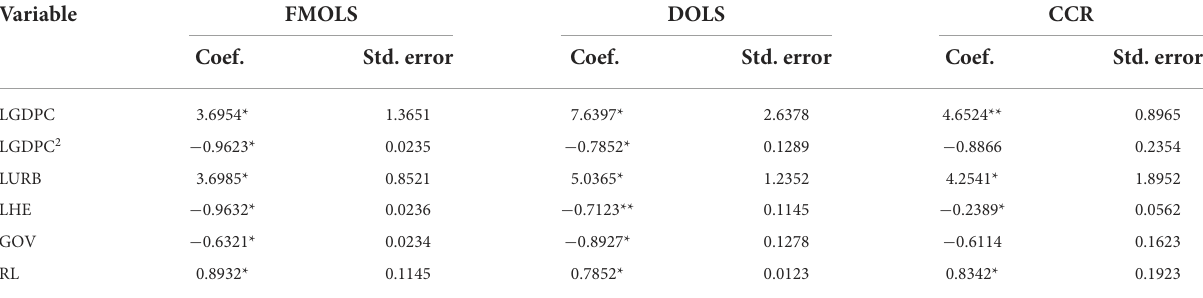
TABLE 7 Outcomes of FMOLS, DOLS and CCR estimators. Variable FMOLS DOLS CCR Coef. Std. error Coef. Std. error